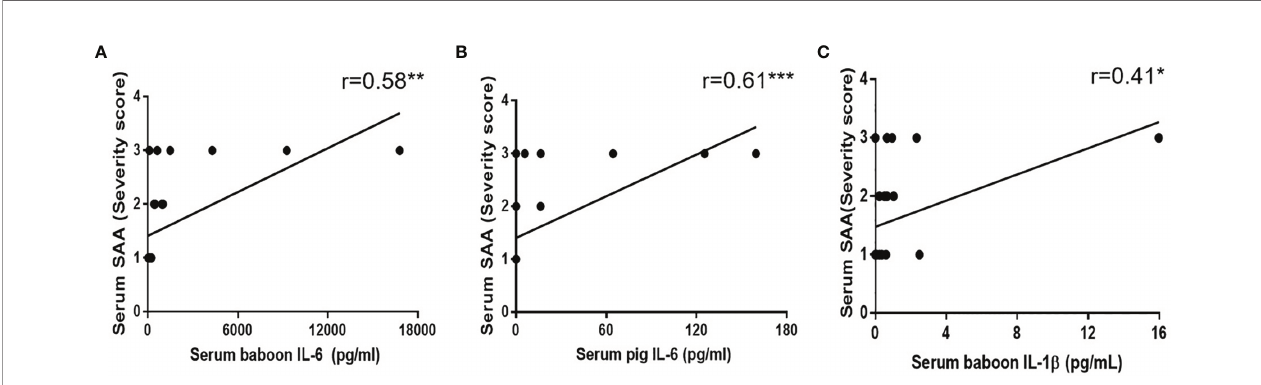
FIGURE 6 | Correlation between SAA score with (A) serum baboon IL-6, (B) serum pig IL-6, (C) serum IL-1 b . Signi fi cant positive correlations were found between SAA score and serum baboon IL-6 (**p < 0.01), serum pig IL-6 (***p < 0.001) or serum IL-1 b (*p < 0.05).